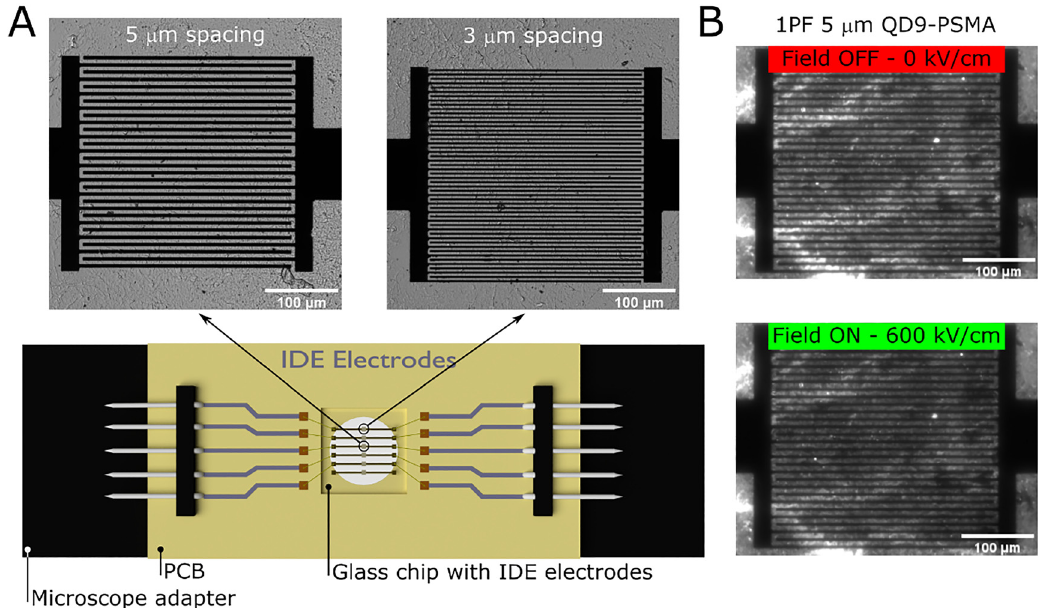
Figure 1: A. Illustration of a PCB with a central glass chip containing an array of IDEs with 5 or 3 µm separation. The bright fi eld microscopy imagesshowbothoftheseelectrodescoatedwithcollagen/QD9-PSMA;B.1PFimageofthequasi-type-IIQD9-PSMAona5µmspacedIDEwith the E- fi eld switched OFF or ON (600